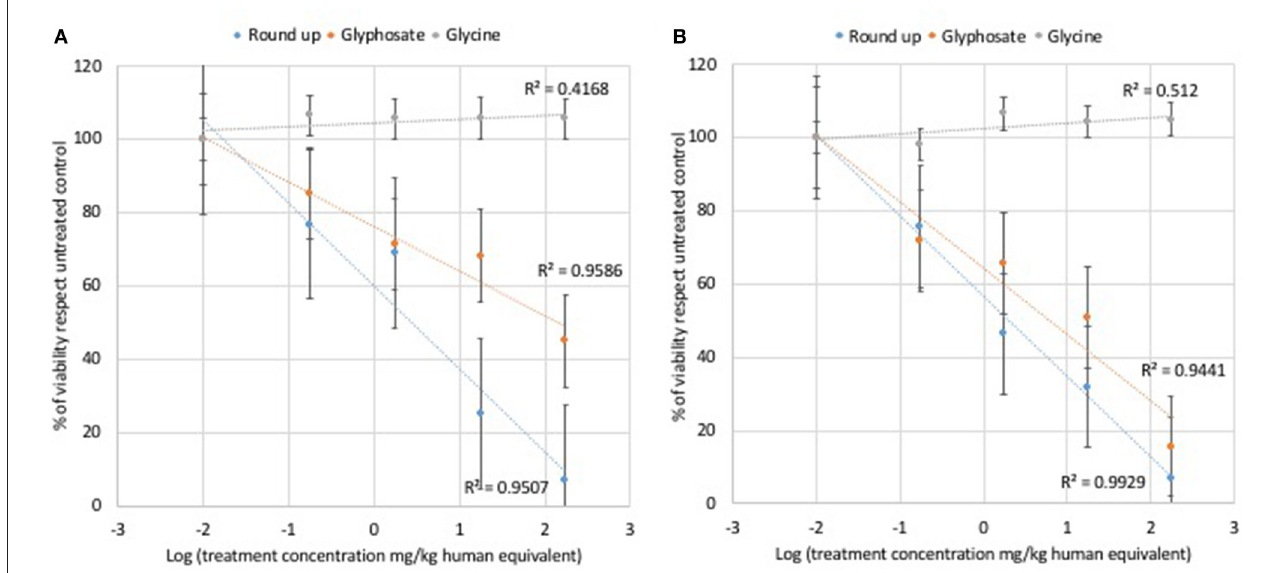
FIGURE 3 | Relationship between pure glyphosate, Roundup Bioflow, and glycine at the dose range 0–175mg kg − 1 (human equivalent) (Log scale) and cell viability of L929 fibroblasts (A) and Caco2 cells (B) . Data are expressed as mean value ( ± st. dev.) (% compared to control). R 2 , coefficient of determination.